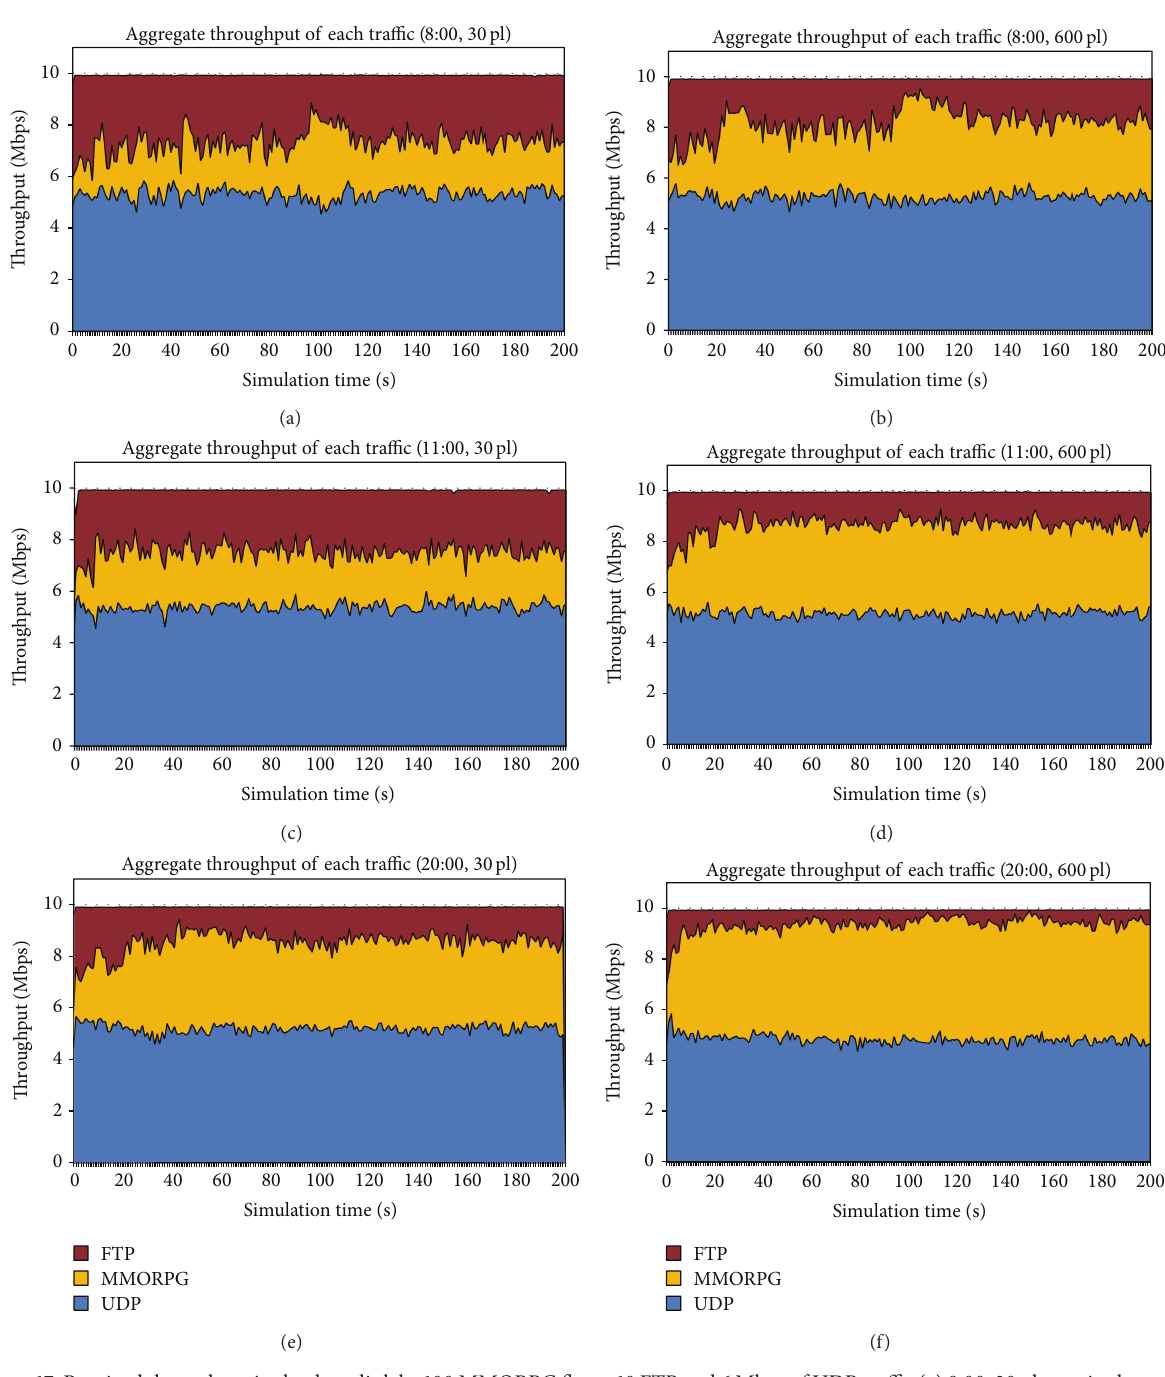
Figure 17: Received throughput in the downlink by 100 MMORPG flows, 10 FTP and 6Mbps of UDP traffic (a) 8:00, 30 players in the servers; (b) 8:00, 600 players in the servers; (c) 11:00, 30 players; (d) 11:00, 600 players; (e) 20:00, 30 players; (f) 20:00, 600